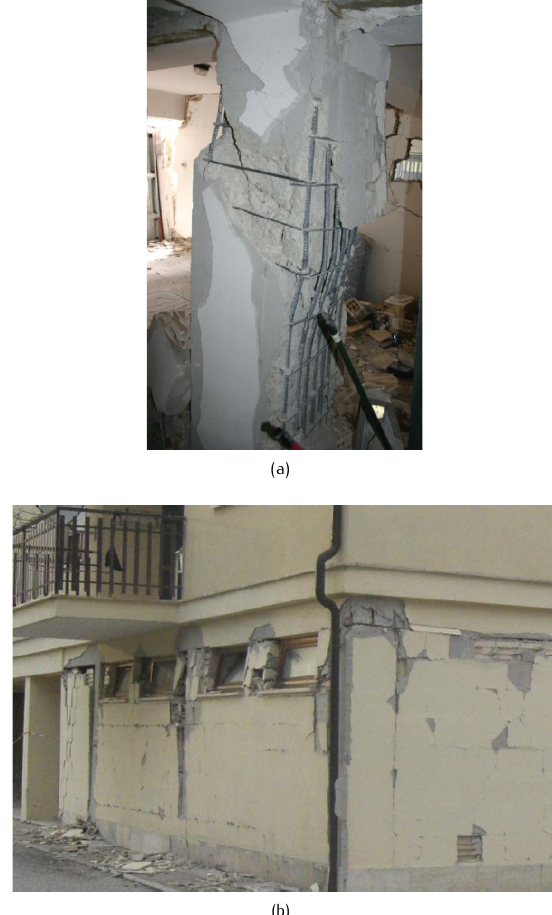
Figure 4. Examples of column shear failure [1].